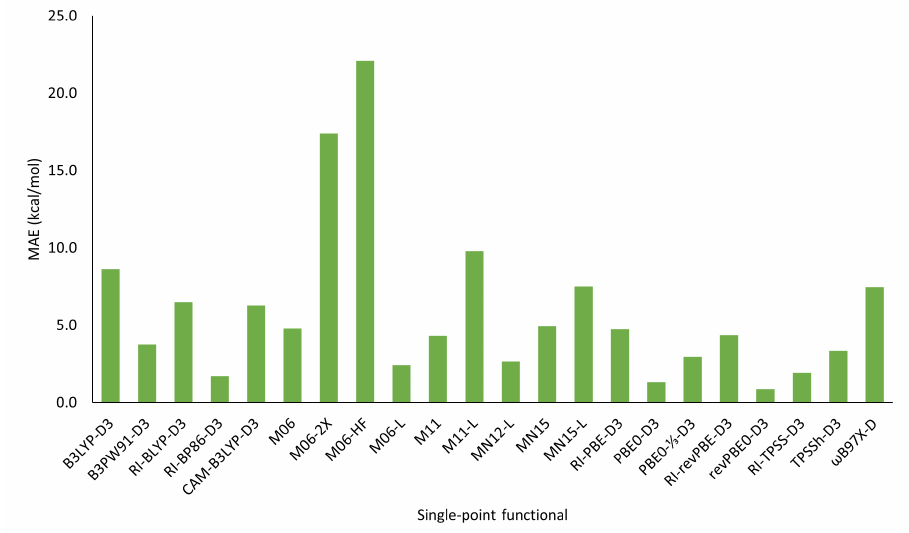
Figure 1. MAE in the calculation of hydricity across each of the three complexes with a range of single-point functionals. Performed with implicit solvation (PCM MeCN ) and a def2-TZVP basis on optimised geometries from RI-BP86-D3(PCM MeCN